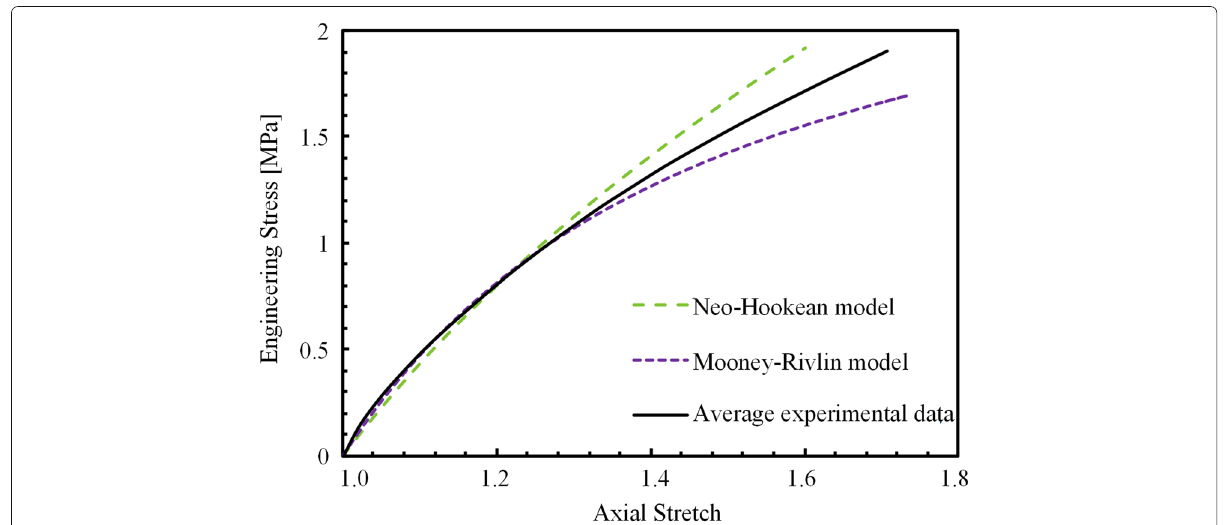
Fig. 6 Curve-fitting of hyper-elastic material models to uni-axial material testing data